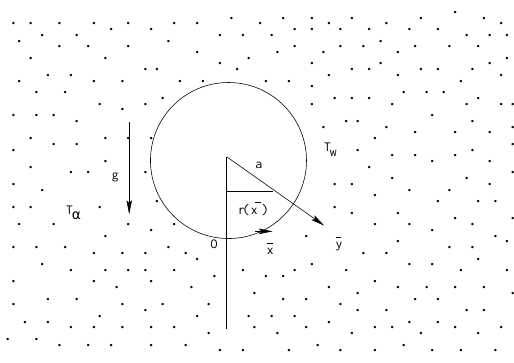
Figure 1. Sketch of the physical model and the coordinate system.